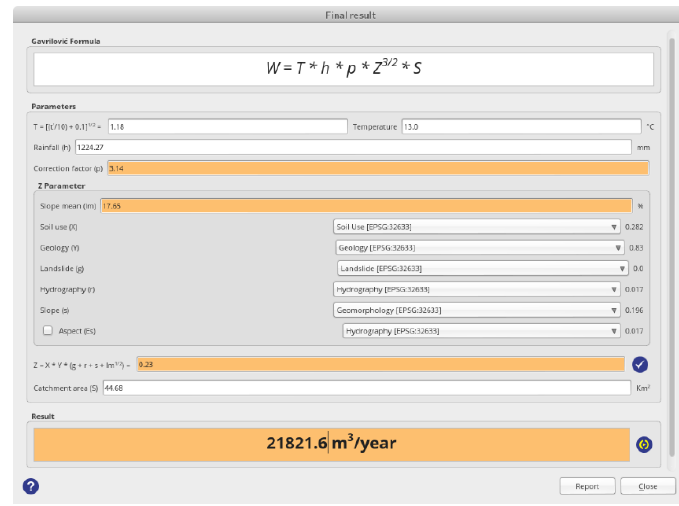
Figure 5. Graphical User Interface of stage 4 showing the result of the EPM application and summarizing the value of each used parameter.